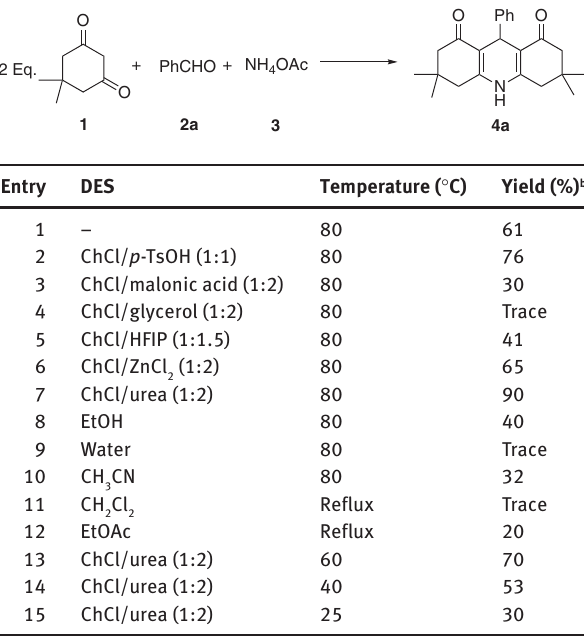
Table 1 Survey on the solvent effect on the model reaction. a